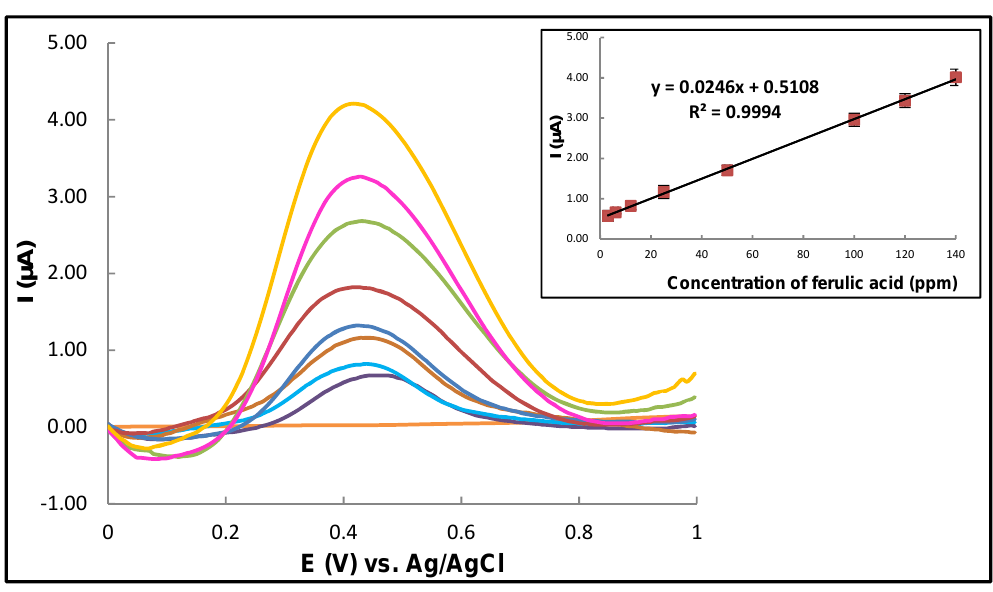
Figure 5. Differential pulse voltammograms of ferulic acid (3, 6, 12, 25, 50, 100, 120 and 140 ppm) in 0.1 M sodium acetate buffer solution (pH 5, measured under the optimal experimental conditions (see text).Data shown are representative of that seen in 3 independent repeats, or (insert) are shown as the mean ± 1 SD derived from the same independent